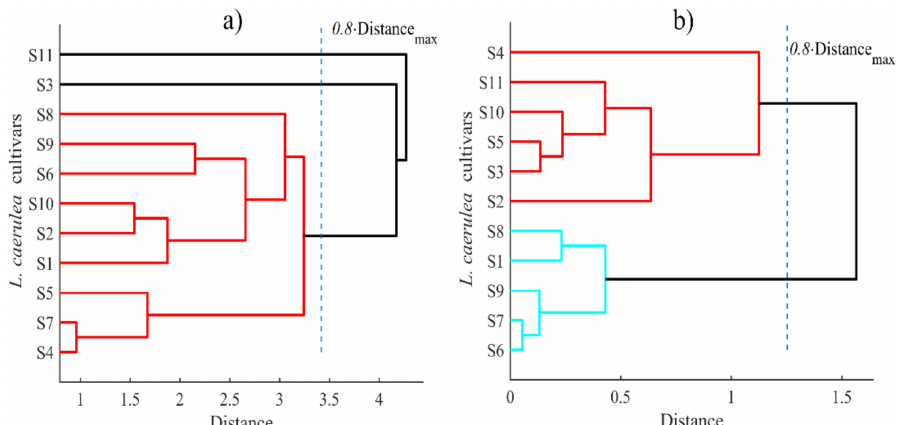
Figure 3. Grouping of Lonicera caerulea cultivars according to the antibacterial activity: ( a ) ethanolic extracts; ( b ) aqueous extracts (sample codes are listed in Table 1). Table 7. Correlation matrix between tested berry variables (TPC, total phenolic content; TAC, total anthocyanins